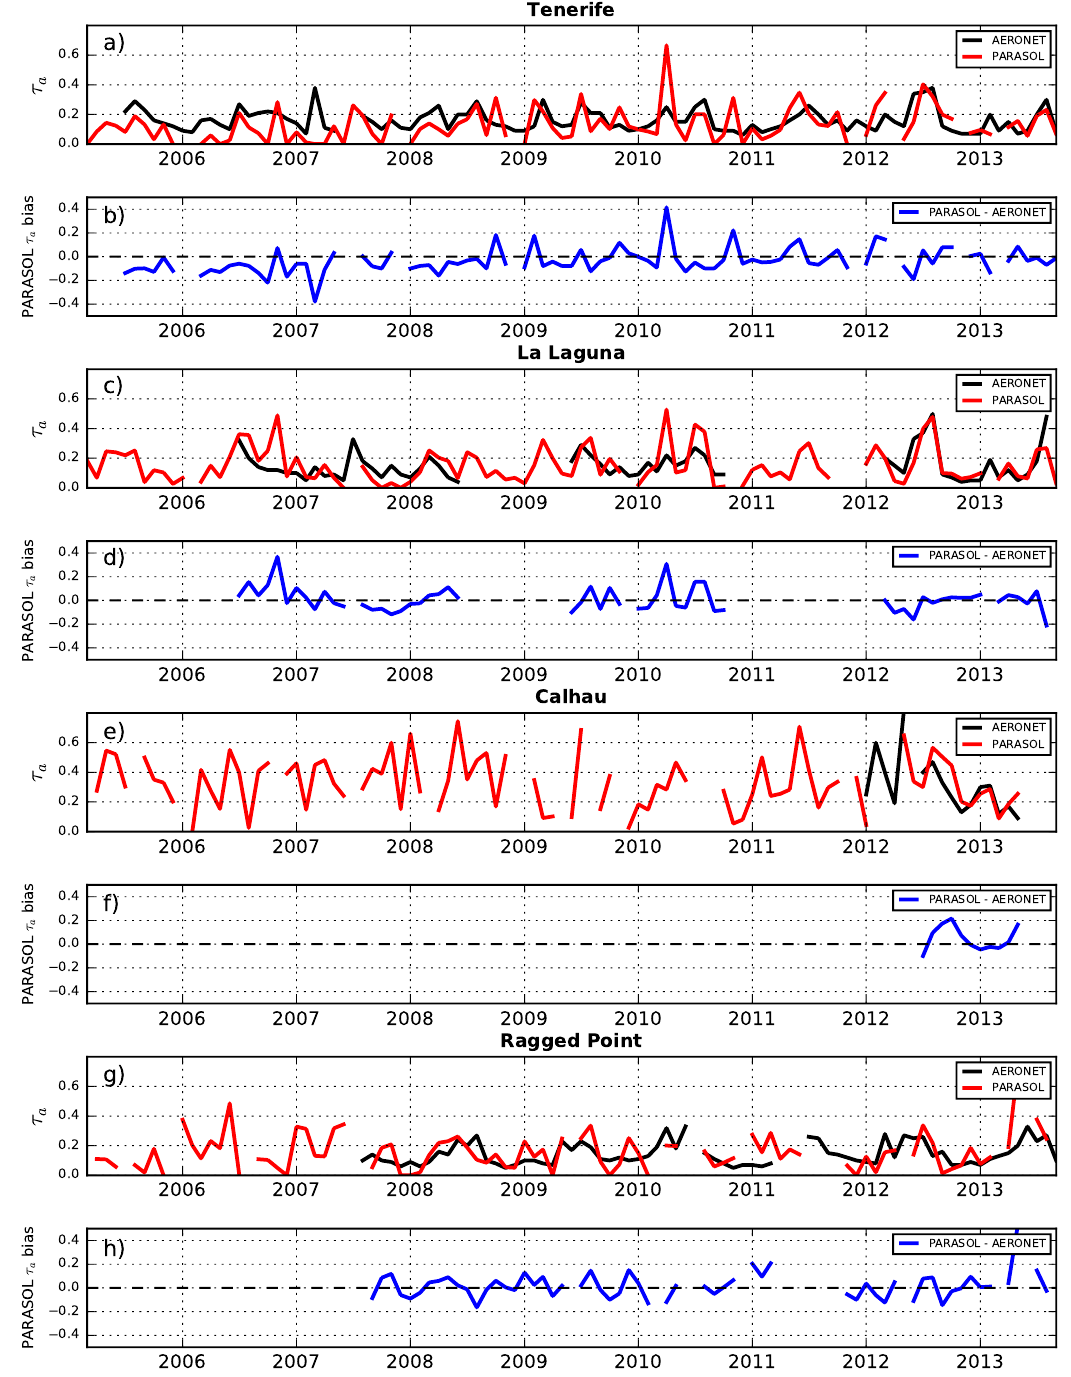
Figure 2. Comparisons of the total AOD (i.e., fine + coarse mode) monthly mean at 550 nm between PARASOL observations (red point) and AERONET measurements (black curve) from 2005 to 2013: ( a ) Tenerife, ( c ) La Laguna, ( e ) Calhau and ( g ) Ragged Point. Corresponding PARASOL AOD bias with respect to AERONET AOD: ( b ) Tenerife, ( d ) La Laguna, ( f ) Calhau and ( h ) Ragged